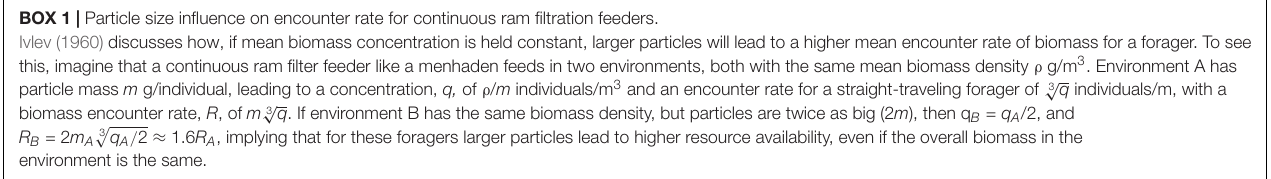
Frontiers in Marine Science |